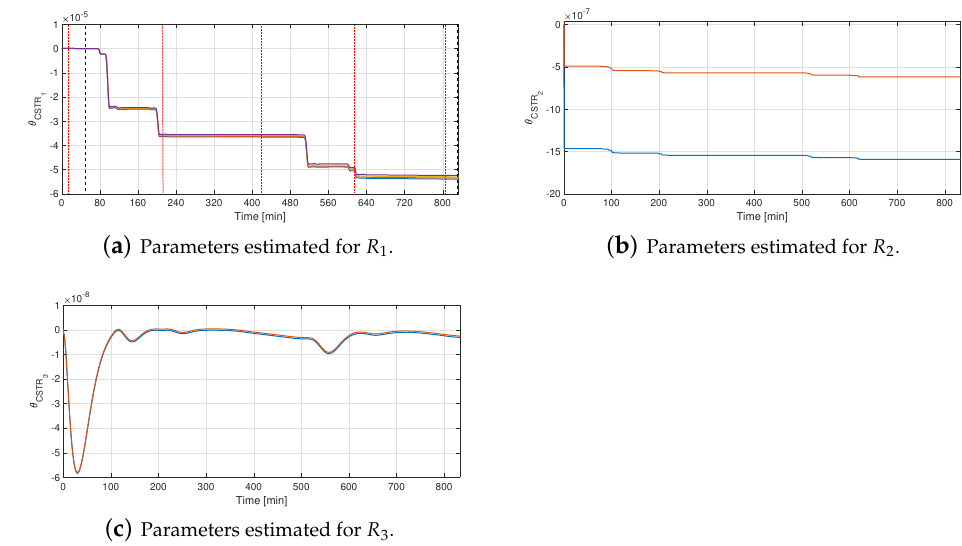
( c ) Parameters estimated for R 3 . Figure 17. Performance of adaptive controller under a simultaneous disturbance—Parameter